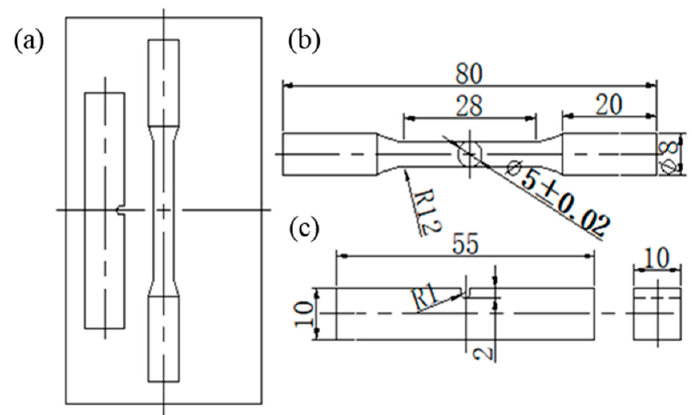
Figure 3. Plate material after thermomechanical treatment: ( a ) the sampling schematic; ( b ) standard tensile sample; ( c ) standard impact sample.